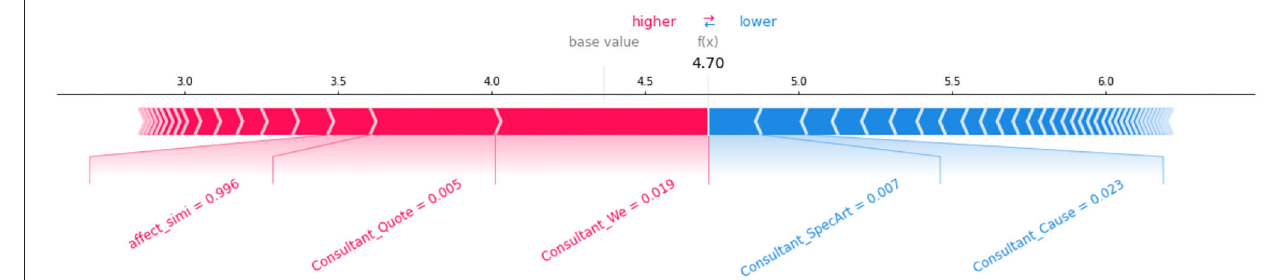
FIGURE 9 | SHAP force plots supporting the local interpretability with a specific prediction.